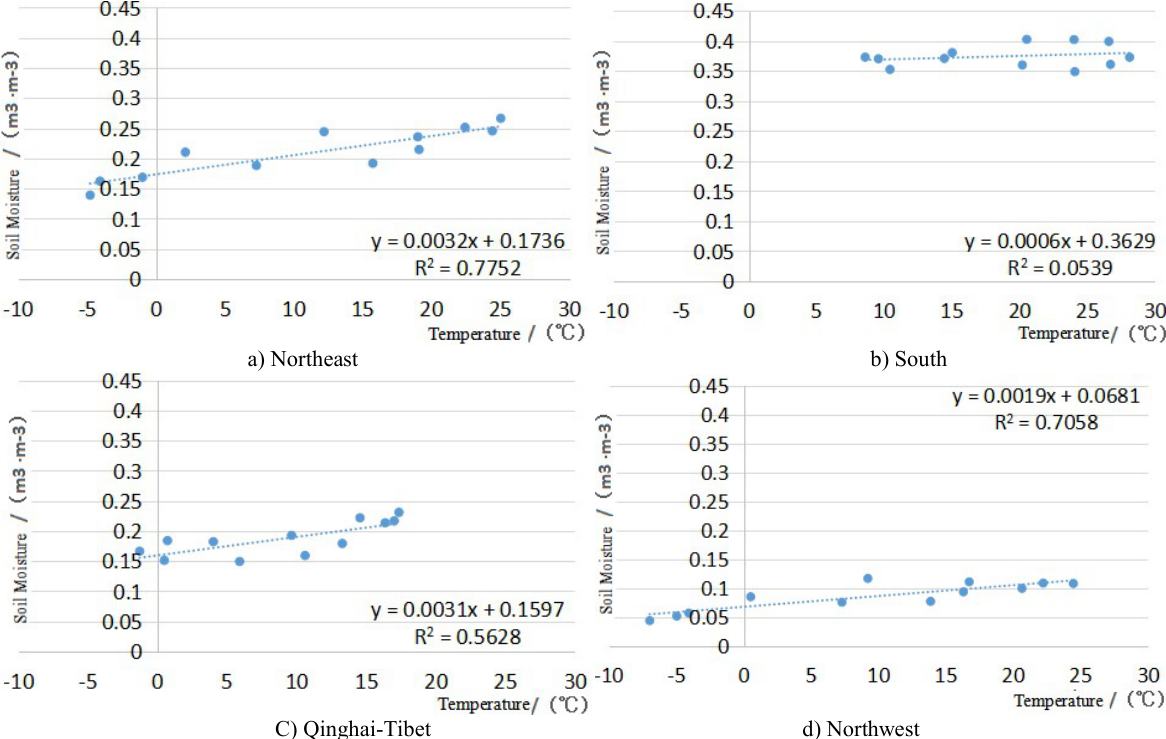
Figure 6 the linear relationship between soil moisture and